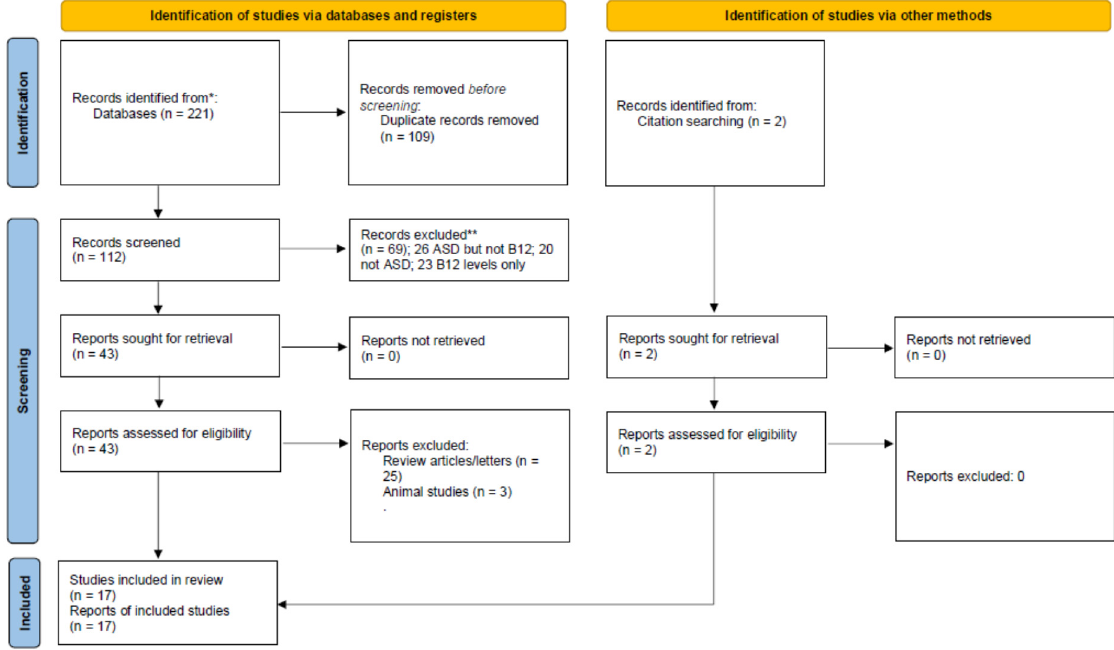
Figure 2. PRISMA 2020 flow diagram for this systematic review.